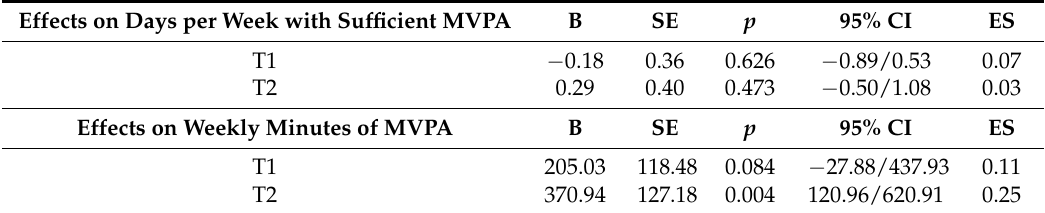
Table 2. Difference in physical activity (PA)-outcomes between Active Plus65 and reference group. Effects on Days per Week with Sufficient